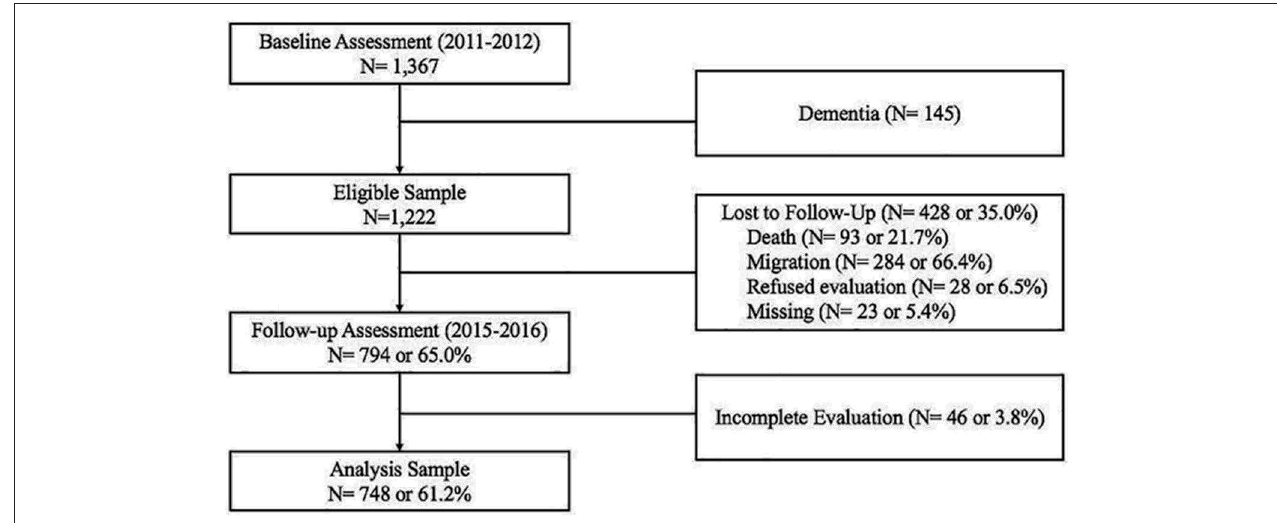
FIGURE 1 | Flow chart of study